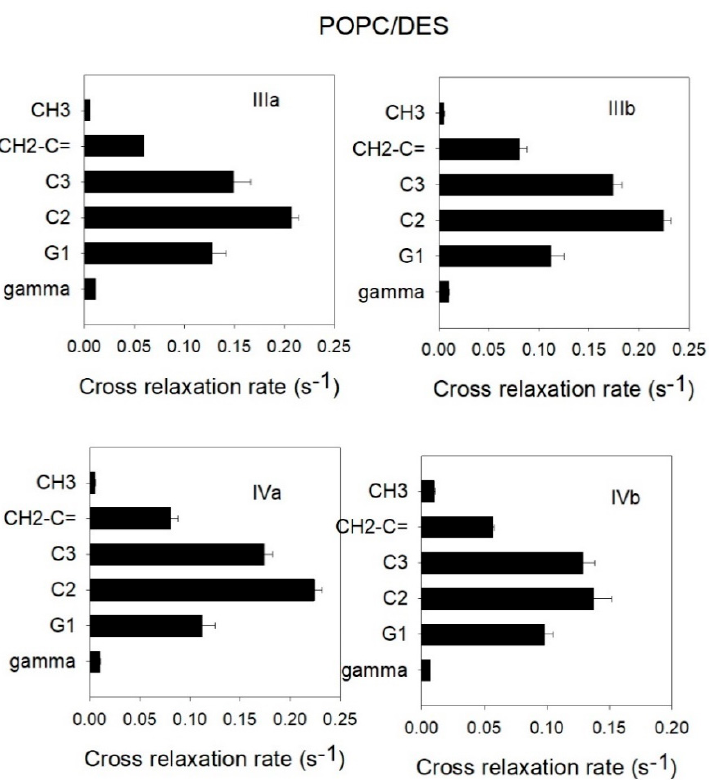
Figure 6. Cross-relaxation rates obtained from the 1 H-NMR-NOESY spectrum of POPC (1-palmitoyl-2-oleoyl- sn -glycero-3-phosphocholine)/DES. Cross-relaxation rates corresponding to the protons bound to the different POPC groups along the long axis of the molecule from the center of the membrane to the polar group (shown in ordinates) with respect to the DES carbons identified in each panel (see Figure 1 to identify the different DES protons studied). Mean values ± standard deviations (five determinations).